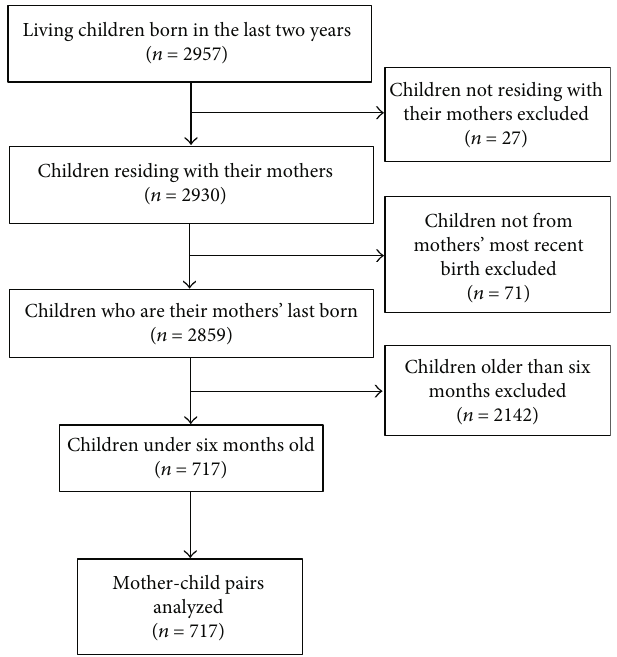
Figure 1: Flow of sample selection based on CDHS 2014